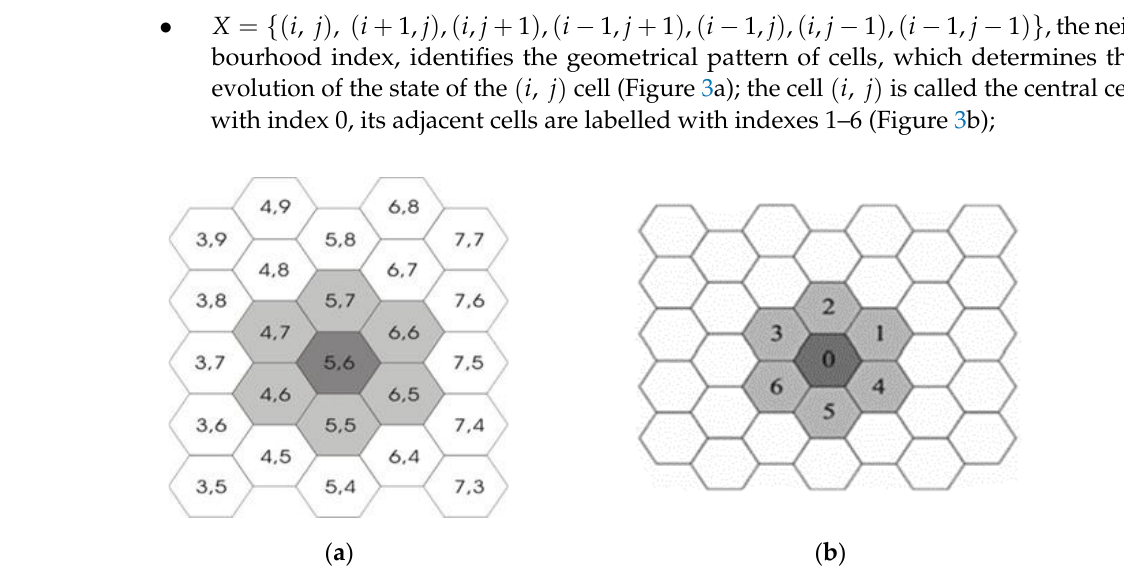
Figure 3. ( a ) A fraction of the cellular space with neighboring cells surrounding the central cell (5,6) in dark grey; ( b ) neighboring indexes.